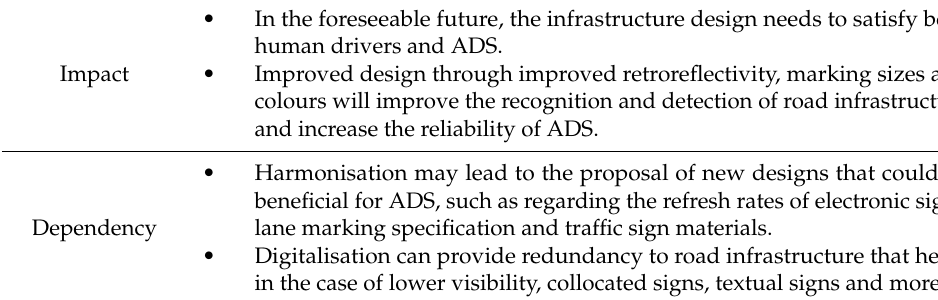
Table 11. Summary of impacts and dependencies of design.